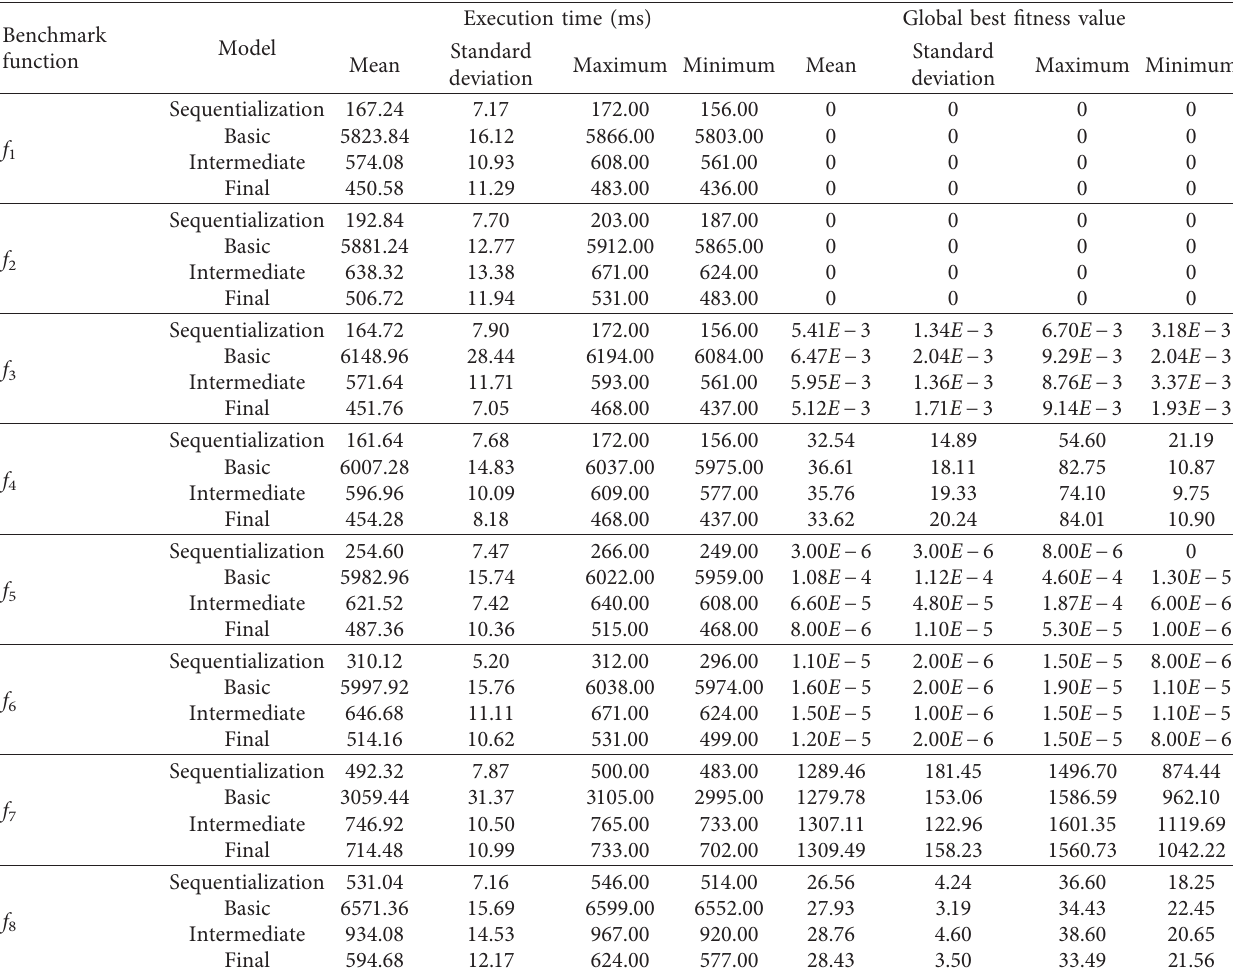
Table 3: Statistical execution time and global best fitness results of the sequentialization model and the coarse-grained all-GPU models on all the benchmark functions.